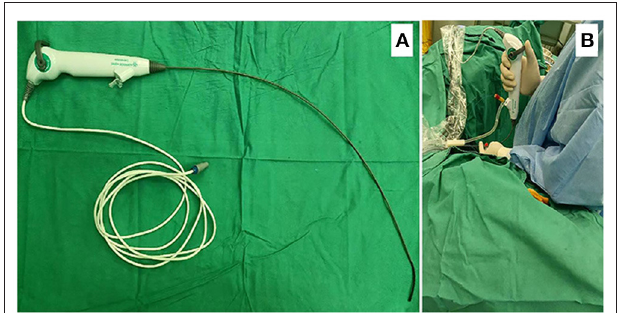
FIGURE 1 | (A) Chinese single-use FURS ZebraScopeTM (Happiness Workshop): The outer diameter of the front end of the lens is F7.4, and the maximum outer diameter of the lens is F8.6. The operating channel is a single channel with an inner diameter of F3.6. The steering angle of the mirror head end is 1:1, and the minimum bending radius is about 8mm. The head end can bend more than 270 in both no-load. (B) Application of the single-use digital FURS ZebraScopeTM during